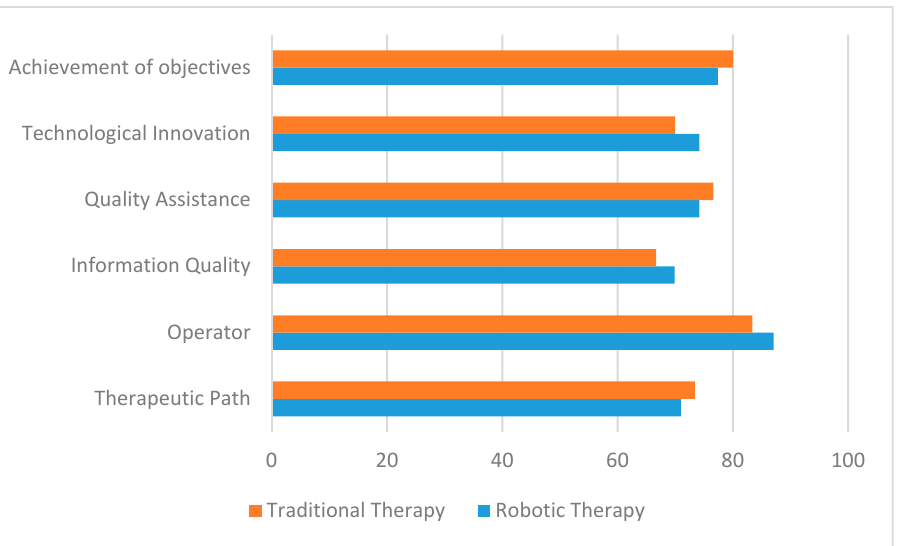
Figure 1. Degree of satisfaction expressed by parents: comparison between traditional and robotic therapy.